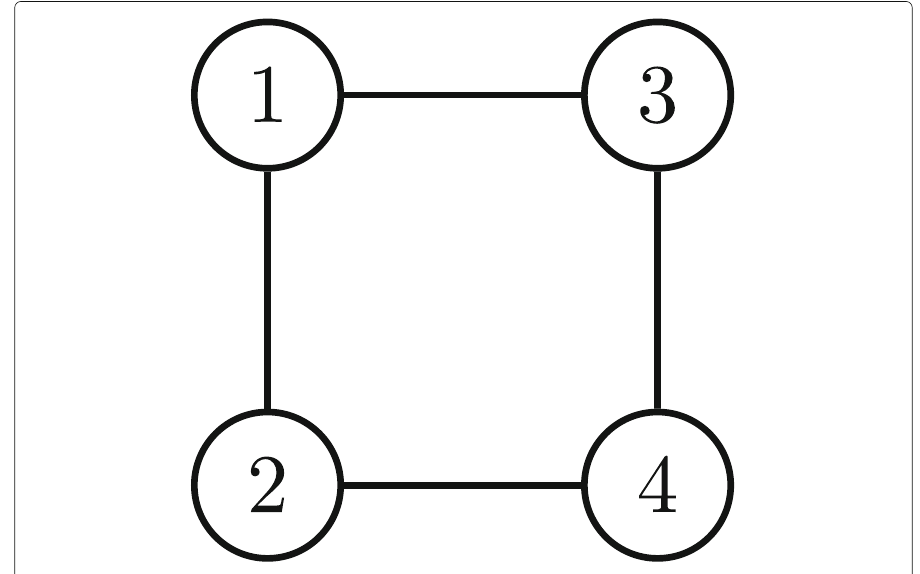
Fig. 2 Inverse graph of integer modulo